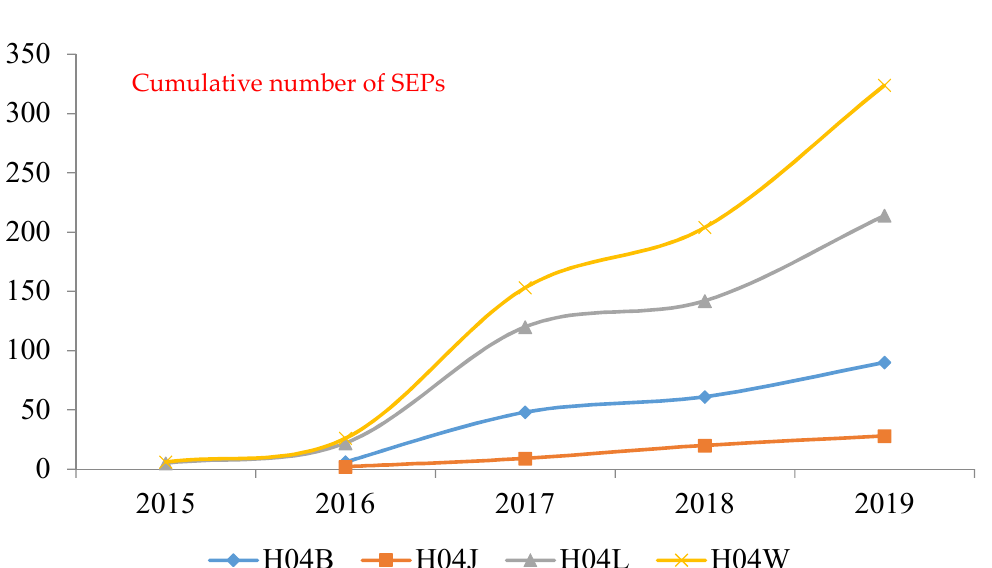
Figure 3. Yearly changes in the key technologies in SEPs optical networks. Note: The cumulative number of SEPs denotes the accumulated number of SEPs each year.